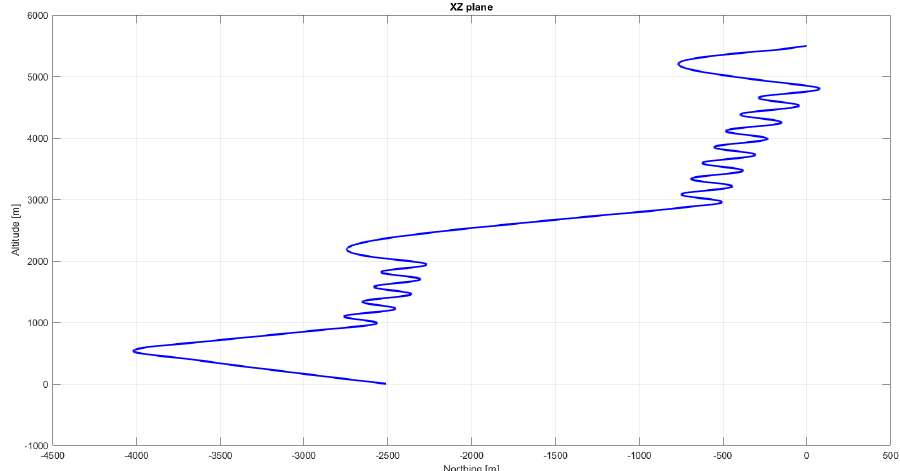
Figure 7. Reference trajectory during drop-test as provided by TAS − I. The control deflections are an input to the dynamic model provided by TAS − I.